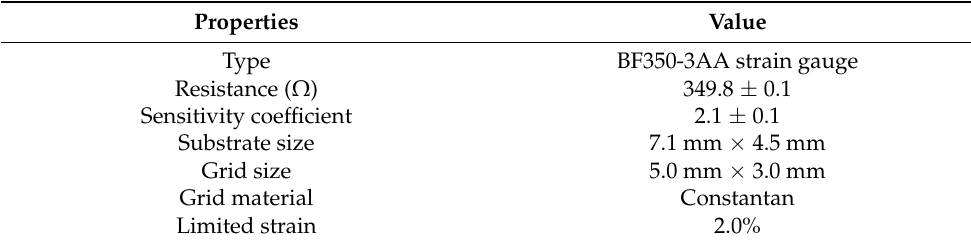
Table 3. Specifications of the strain gauge.